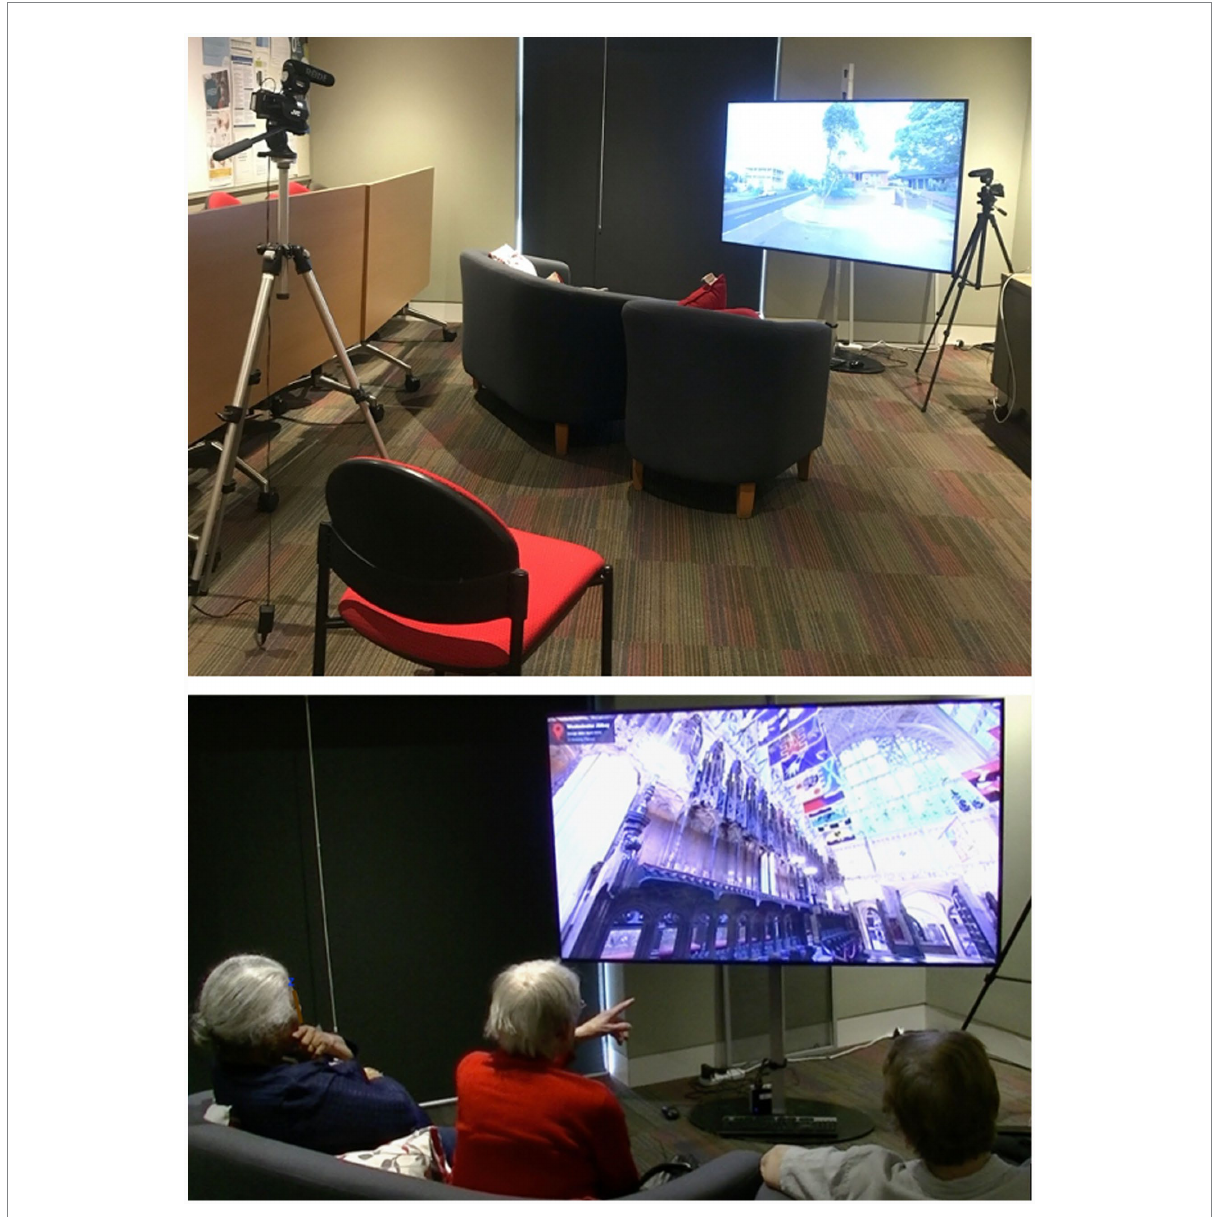
FIGURE 1 The Time Travelling with Technology (TTT) program environment. The older adults sit in an arc around the television and view locations that are specific to adults in the session. One camera was located next to the screen facing the participants face on, to capture facial movement and audio. A second camera was facing the screen and was situated behind the participants to capture the locations viewed across the session. The facilitator sat on the floor next to the television facing the participants and used a tablet device to drive the TTT